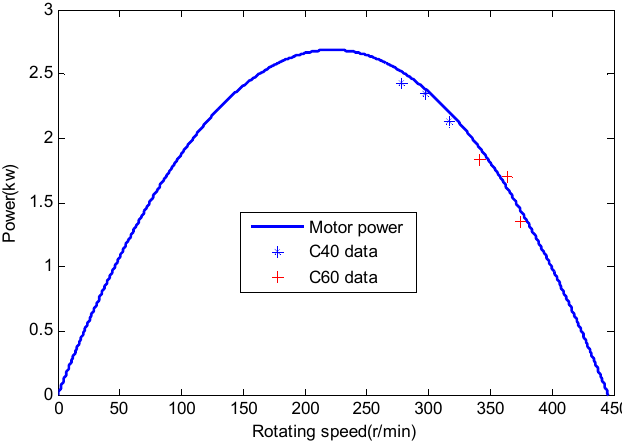
Figure 14. Curve of the rotation speed and torque of the pneumatic motor.